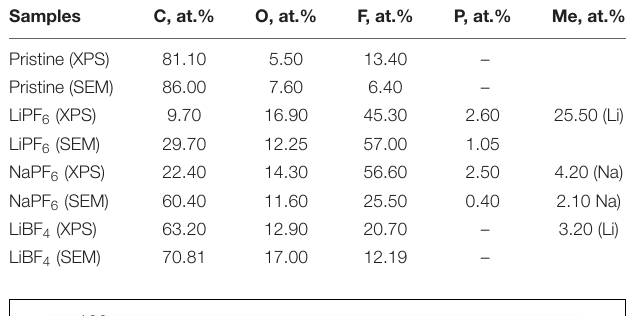
TABLE 2 | Element content (at. %) for YP-50F determined from XPS and SEM/EDS analysis for pristine and worked electrodes in different electrolytes after CV-tests.